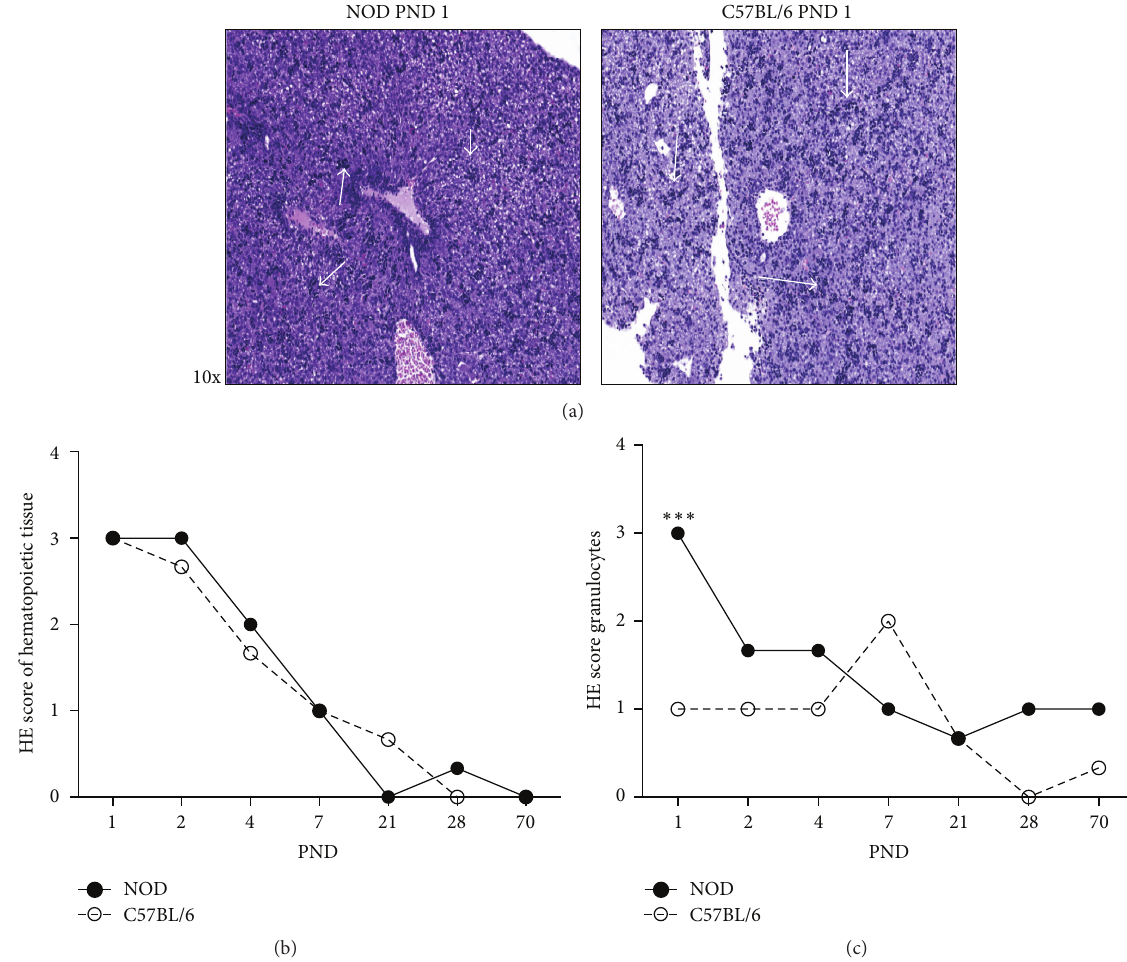
Figure 2: The presence of granulocytic myeloid derived cells is high in NOD mice livers. (a) Hematoxylin and eosin (HE) staining of neonatal PND 1 liver tissue sections from NOD and C57BL/6 mice. Arrows indicate hematopoietic tissue in the liver of newborn mice at PND 1. 10x magnification. (b) HE scores of hematopoietic tissue at PND 1–70 in NOD and C57BL/6 mice. Two persons evaluated HE score in a blinded fashion ( 𝑛 = 3 ). (c) HE score of granulocytes at PND 1–70. ∗∗∗ 𝑝 < 0.001